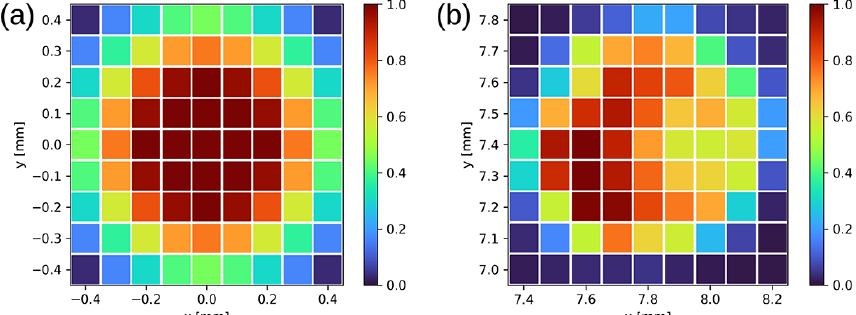
Figure 8. (a) Simulated signal map for a diaphragm of radius r d = 0 . 4mm and an image of radius r i = 0 . 2mm. The signal is normalized by the maximum value. (b) Result of a single-plane mapping performed with misaligned optics; here the signal (normalized by the maximum value) is asymmetrically clipped by the optical system between the telescope and the